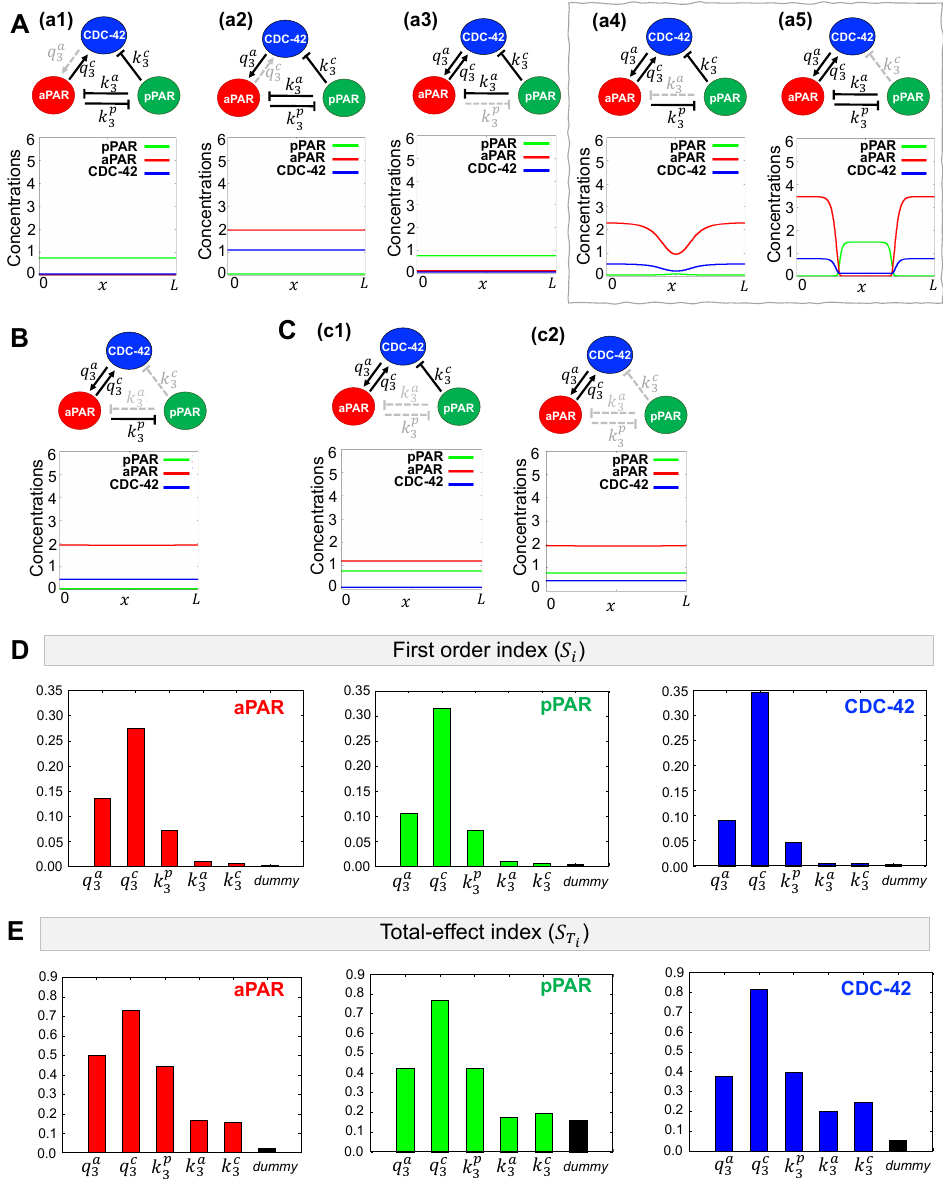
Figure 4. Minimal network needed for generation of Par protein polarization. ( A – C ) Representative simulations for the indicated network. Dotted gray lines indicate interactions excluded from the network. The initial condition provides a small local perturbation, as discussed in Section 2.4. Simulation results are shown at t = 30, longer than the time scale for polarity emergence reported experimentally [30]. ( A ) (a1)–(a5) Simulation results of networks omitting a single interaction. Networks boxed in gray are minimal networks capable of generating a polarization pattern. ( B ) and ( C ) (c1)–(c2) Simulation results of networks omitting two or more interactions. ( E – F ) Variance-based sensitivity analysis results using the eFAST method. Both the first order and total effect index indicate the importance of CDC-42 in producing the correct spatial